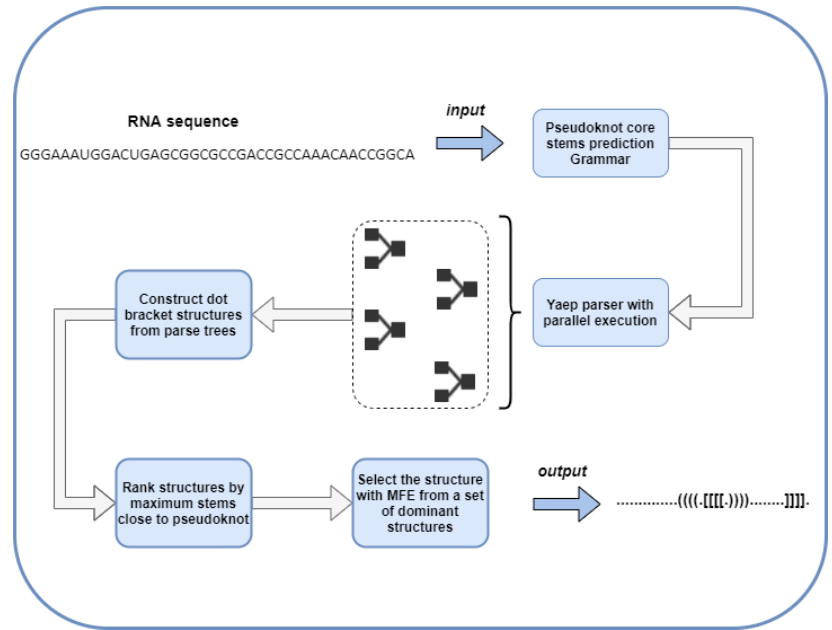
Figure 3. A more extensive representation of our